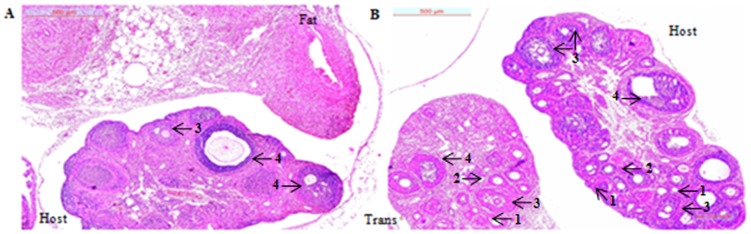
Ovarian architecture.Histological sections demonstrate marked follicle stimulation in the host ovary (host) of the GalTase-exposed rats transplanted (trans) with ovary (GOT) as compared to unstimulated, dormant or atretic follicles in those with fat transplantation (GFT). Each image is one representative of five independent ovaries of the respective groups; bar = 500 µm.